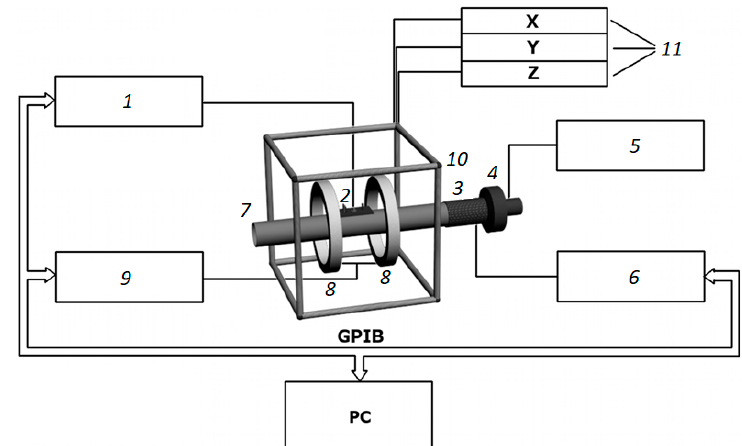
Figure 1. Scheme of THE experimental setup. 1—impedance analyzer; 2—measuring cell; 3—heater;